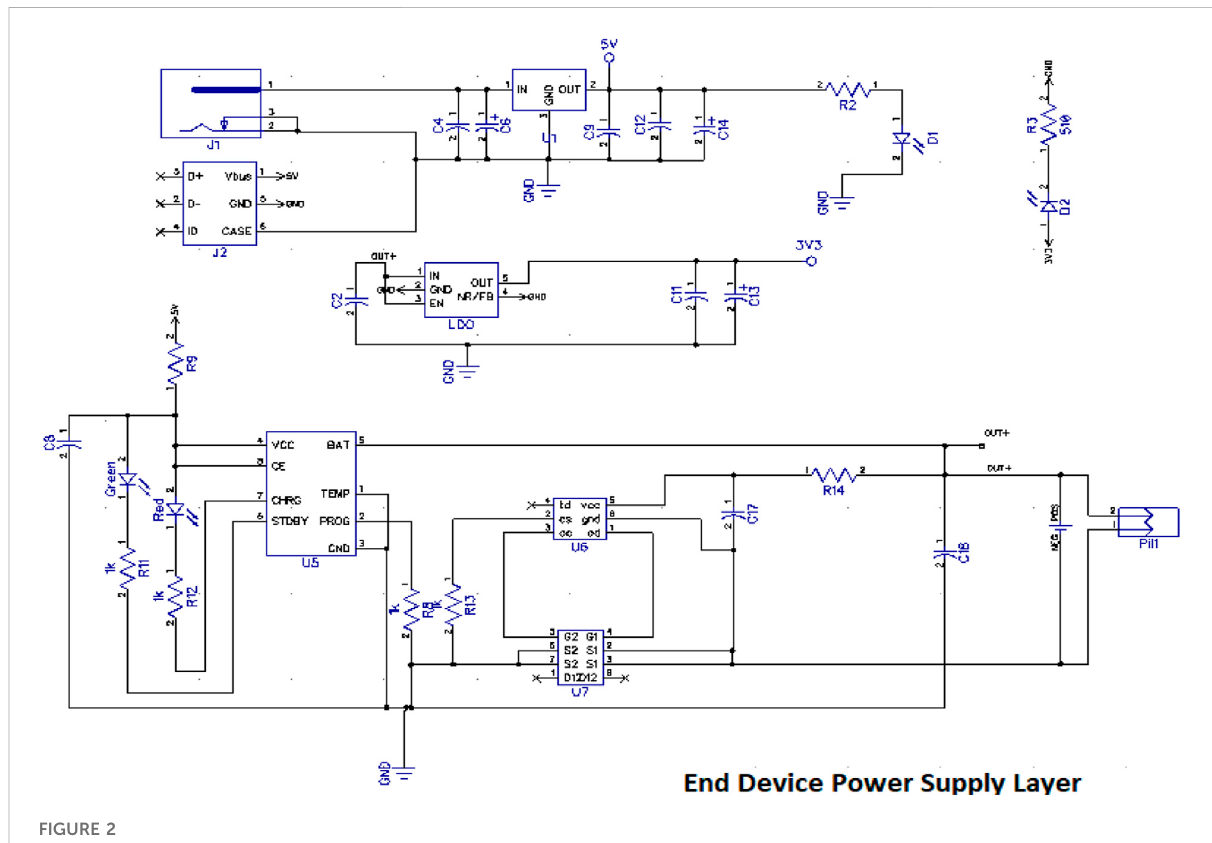
FIGURE 2 Schematic diagram of the end device ’ s power supply layer.